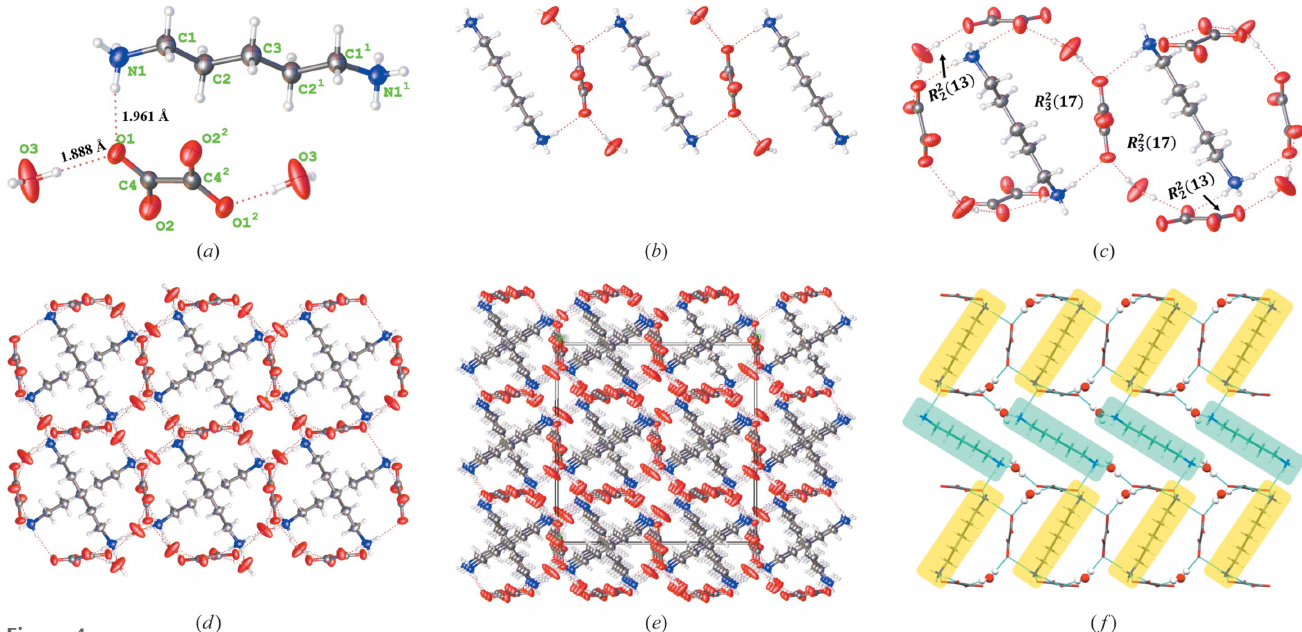
Figure 4 ( a ) Asymmetric unit with the selected atom-labeling scheme of the dihydrate. The ellipsoids are shown at 50% probability. ( b ) Crystal structure of a dinuclear unit of the dihydrate. ( c ) View of the packing structure of the dihydrate with hydrogen bonds between the coordinated water and PDA-OXA (dashed lines). ( d ) 3D supramolecular framework with open 1D channels and and ( e ) packing diagrams along the b axis, respectively. ( f ) The consistency of the ‘voids’ and the reverse arrangement of PDA molecules shown in different